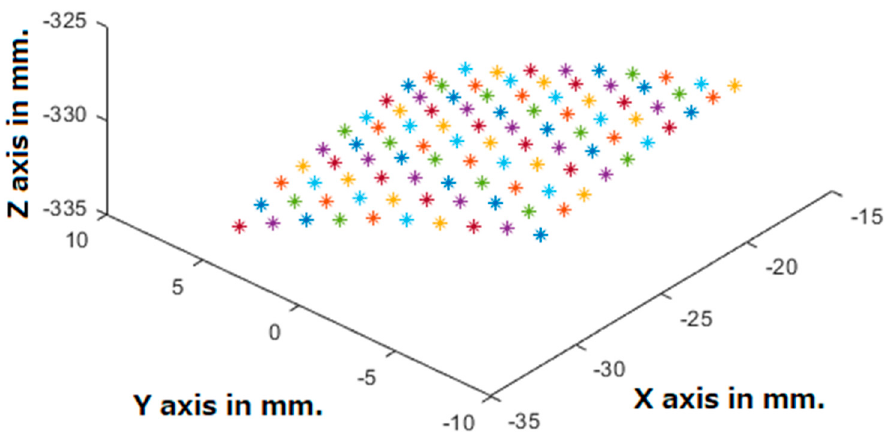
Figure 12. Three-dimensional reconstruction of marks on the metal-sheet surface from point matching.